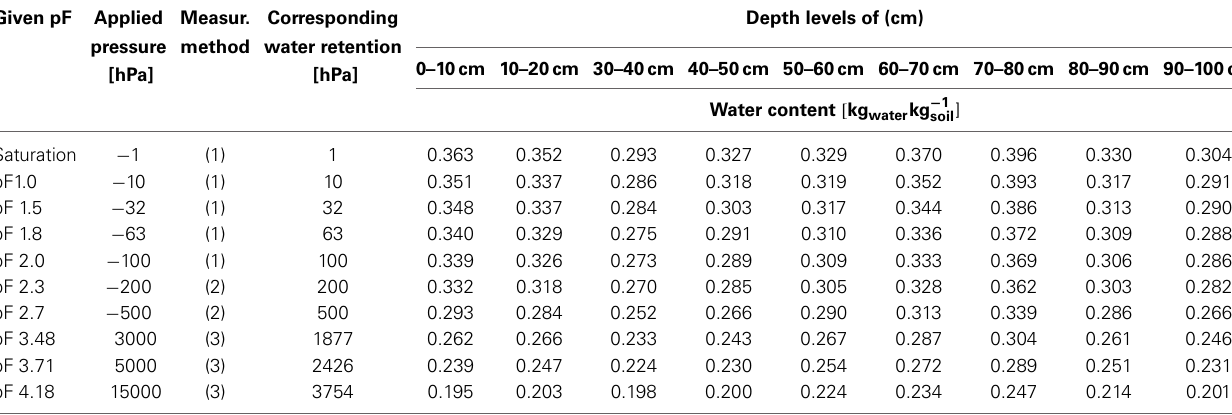
Table 5 | Chimney Meadow (Church Field) soil water retention measurements (pF curves) data. Given pF Applied Measur.